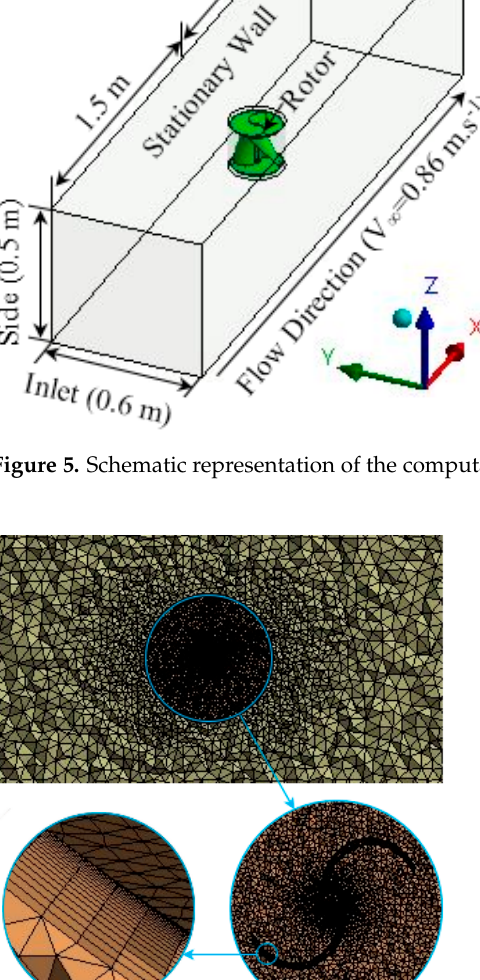
Figure 5. Schematic representation of the computational domain.